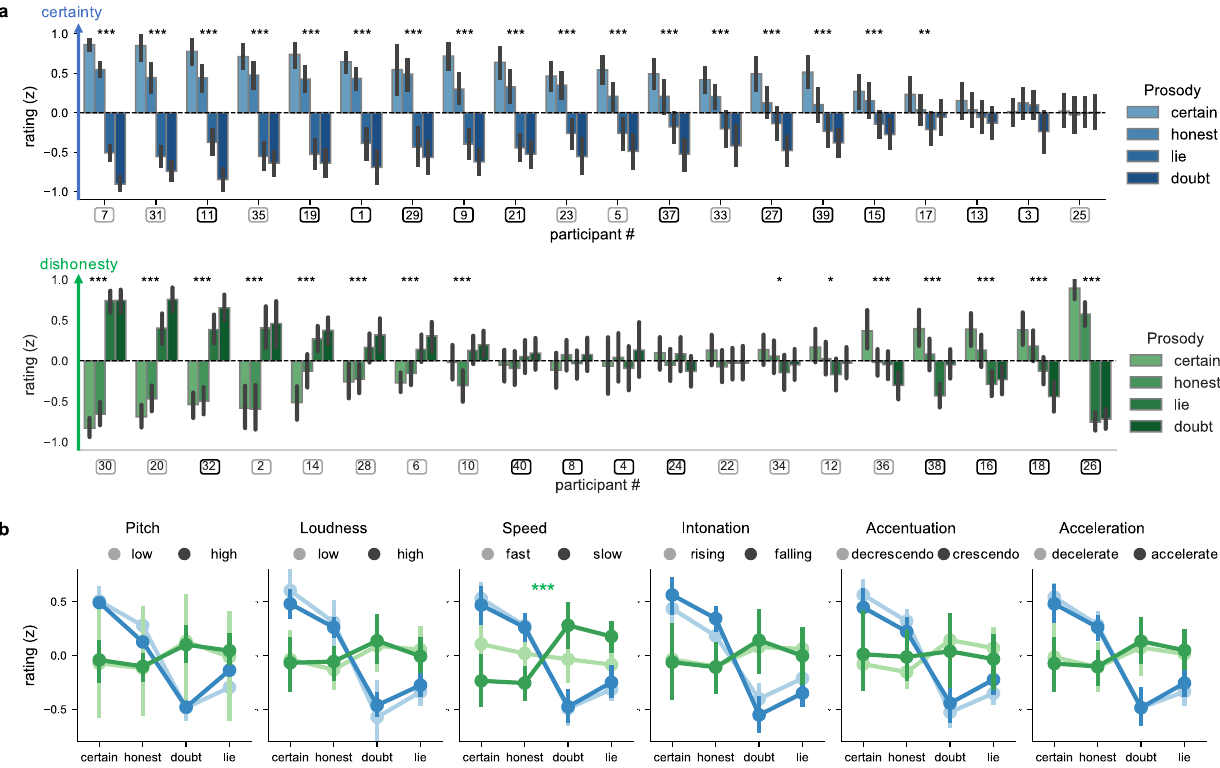
Fig. 3 Relationship between perceptual and conceptual knowledge (study 2B). a Normalized ( z -scored) ratings in the certainty (top, blue; N = 20) and honesty (bottom, green; N = 20) tasks for each participant and prosody type (shown by different hues). Bar plots represent individual participants ’ mean normalized ratings for each prosodic archetype, with error bars showing the 95% con fi dence interval. Data were sorted by effect magnitude. Squared markers below the plot show the listener ’ s gender (black: female; gray: male). Asterisks show the results of paired two-sided sample t tests comparing reliable versus unreliable prosodies for each individual listener, with * p < 0.05; ** p < 0.01; *** p < 0.001 (individual p values are reported in the Source data fi le). At the level of the group, in the certainty task, both honest and certain prosodies were judged as more certain than doubtful (honest: p < 0.001 Bonferroni corrected post hoc Tukey HSD, d = 3.72; certain: p < 0.001, d = 4.14) and lying (honest: p < 0.001, d = 3.23; certain: p < 0.001, d =